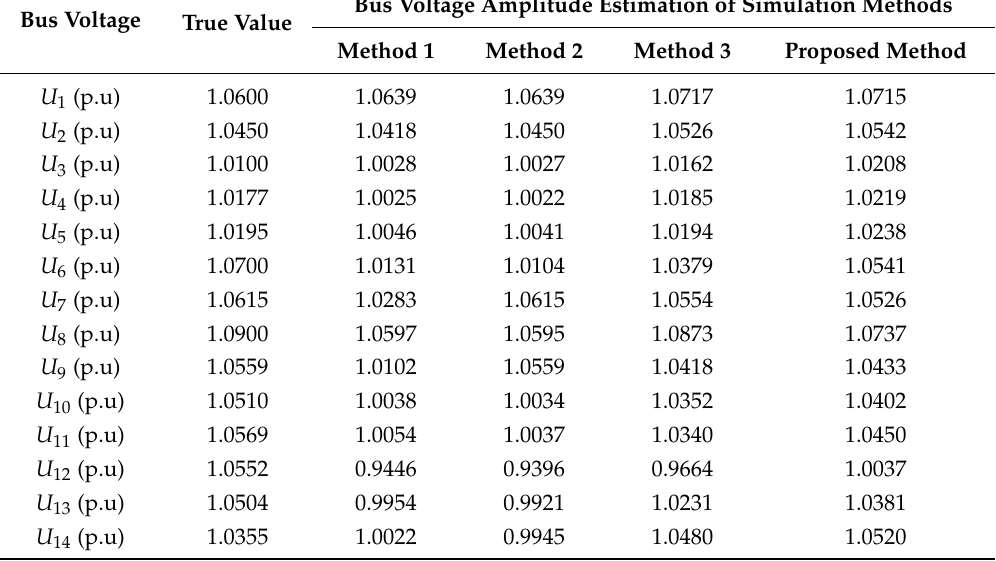
Table 1 presents the bus voltage amplitude estimation results of the four methods in the 14 bus system. The second column indicates the true value of the bus voltage amplitude, and the third, fourth, fifth and the sixth columns show voltage state estimated values using different methods. Table 2 is the bus voltage angle estimation results of the four methods in the 14 bus